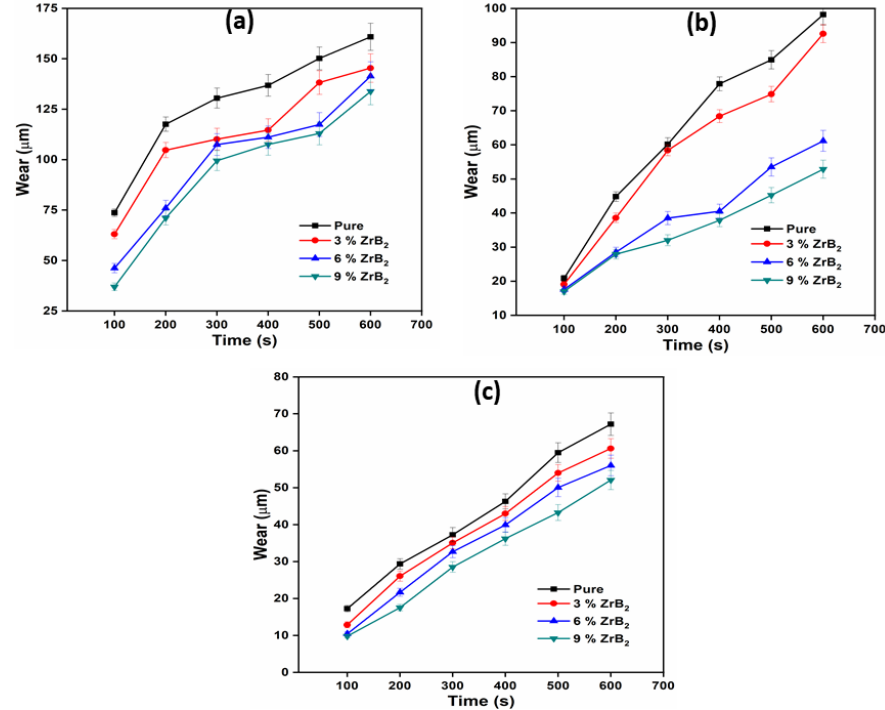
Figure 5. Variation of wear with time at 10N at ( a ) 600 RPM; ( b ) 400 RPM; ( c ) 200 RPM.